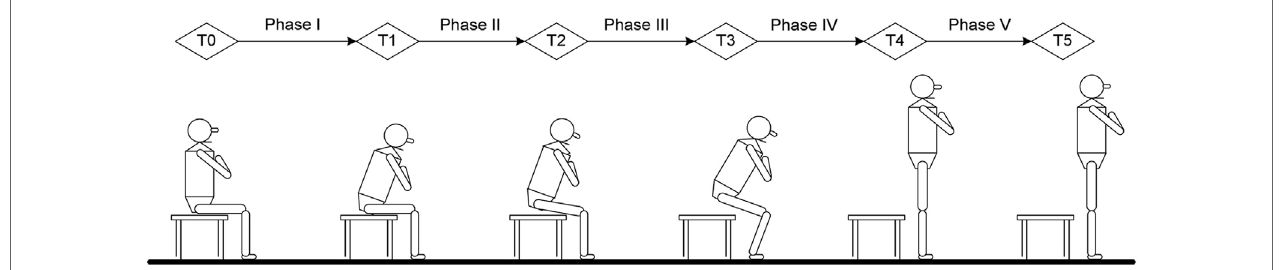
FigUre 1 | Time point and phase definition in current study: T0, initial point of trunk flexion; T1, point of maximal hip flexion; T2, point of abrupt transitory knee extension; T3, point of maximal ankle dorsiflexion; T4, point of just standing with full extension of hip and knee; T5, end of sit-to-stand (stable standing). Phase I, forward transfer of trunk; Phase II, hip lifting off the chair and maximal hip flexion; Phase III, transitory knee extension point to maximal ankle dorsiflexion; Phase IV, maximal ankle dorsiflexion to point of just standing up in nearly full extension of the knee and hip; Phase V, stable